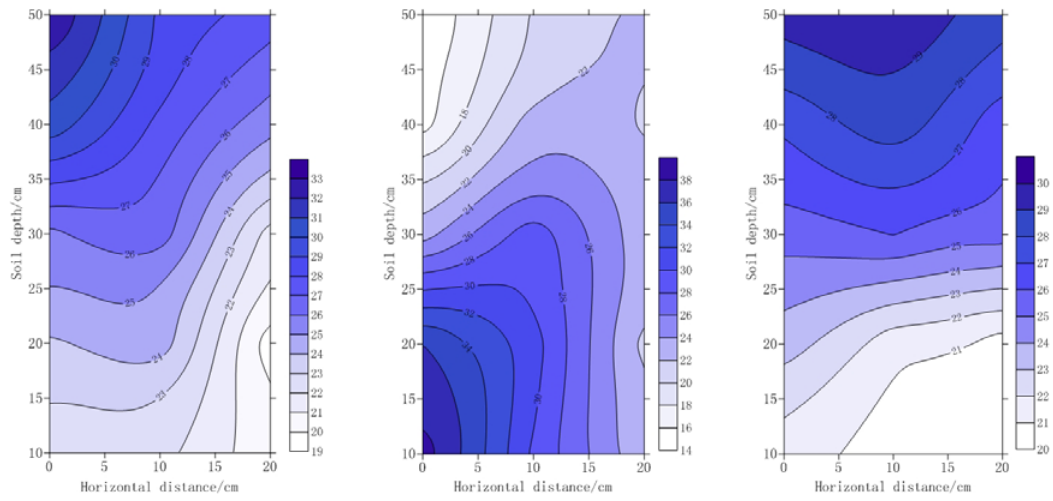
Figure 8. Changes in soil moisture content distributions.